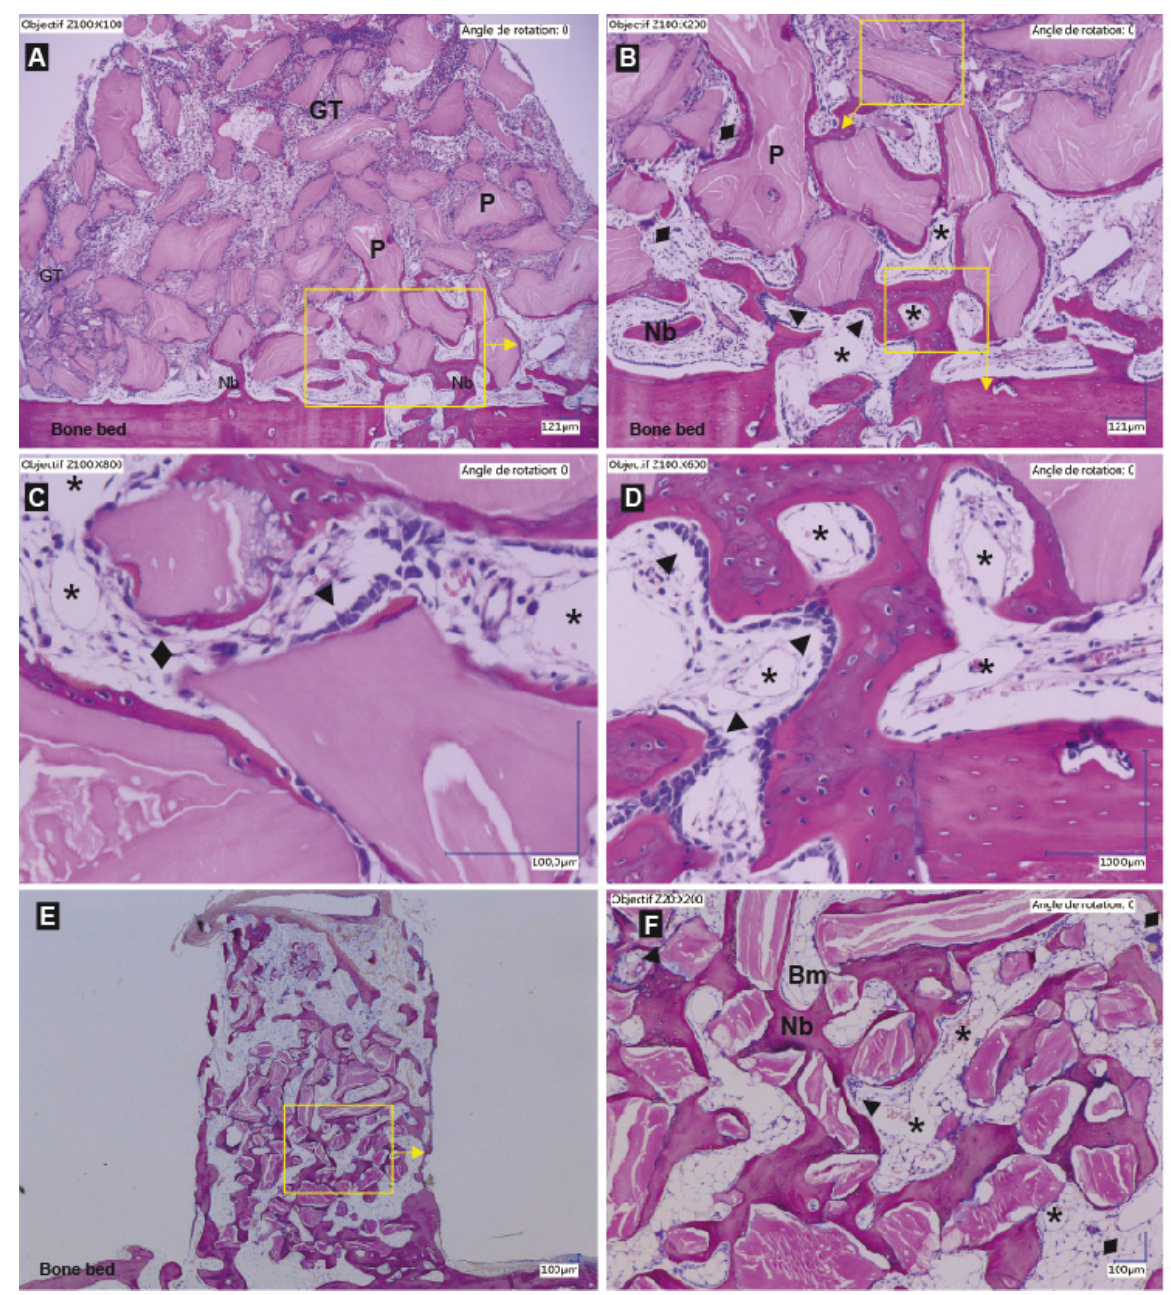
Figure 4. Representative histological slides showing the entire content of a cylinder filled with a DBBM-C scaffold pre-treated with NaCl 0.9% at 2 weeks ( A ) and 12 weeks ( E ) and higher magnifications (( B – D ): 2 wks; ( F ): 12 weeks). Hematoxylin-eosin staining, particles (P) appears as pink, Bone and New bone (Nb) appear as purple. (GT: granulation tissue; Dark arrows ► : lines of osteoblast; Bm: bone marrow; *: capillaries; ♦ : osteoclasts; Yellow boxes and arrows: magnifications on the pictures indicated by the arrows.) ( A ) At 2 weeks, the new bone sprouts from the bone bed and the transcortical holes. Osteoid and new bone tissue are observed in close vicinity to the bone bed. The granulation tissue has already migrated to the top of the scaffold. Below the GT is the osteogenic zone ( B , C ), a highly vascularized tissue where new bone is deposited at the mineral particle surface. Note the lines of osteoblasts that deposit layers of new bone around the particles ( B , C ). Some osteoclasts are also observed at the surface of the particles not yet osseointegrated, followed by osteoblast to form basic multicellular units ( C ). In close vicinity to the bone bed, the remodeling zone is found formed by new bone trabeculae and a vessel rich connective tissue ( D ). At 12 weeks, all the particles are osseointegrated and the bone has filled the whole cylinder ( E ). Note the signs of bone maturation with the presence of bone marrow foci in the bone lacunae as well as the presence of lamellar bone ( F ).